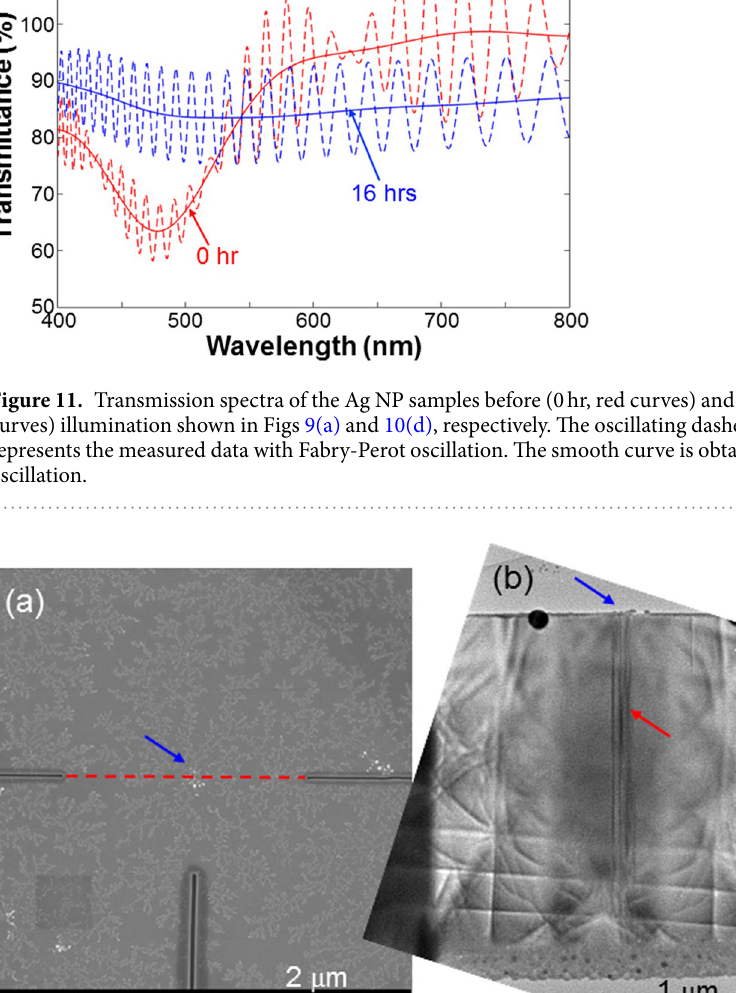
lines of FIB. We use the red dashed line to connect the two horizontal FIB scanning line segments for indicat- ing that the FIB cutting passes the center of a BT, which is pointed by the blue arrow. In other words, using this specimen, we can obtain a cross-sectional TEM image right below the BT center, as demonstrated in Fig. 12(b). Here, right below the BT center, which is pointed again by the blue arrow at the top, there are a few dark lines. Each dark line corresponds to a threading dislocation in GaN. Because of the lattice mismatch between epitaxial GaN and sapphire substrate, threading dislocations are formed in GaN for releasing strain energy. Threading dis- locations can propagate from bottom to top in a GaN layer. Unless a special growth technique is used, threading dislocations of 10 8 –10 9 cm − 2 in planar density are typically formed in growing GaN on sapphire substrate 27 . In With a high-density electron distribution near a threading dislocation, Ag + ions nearby are first neutralized and